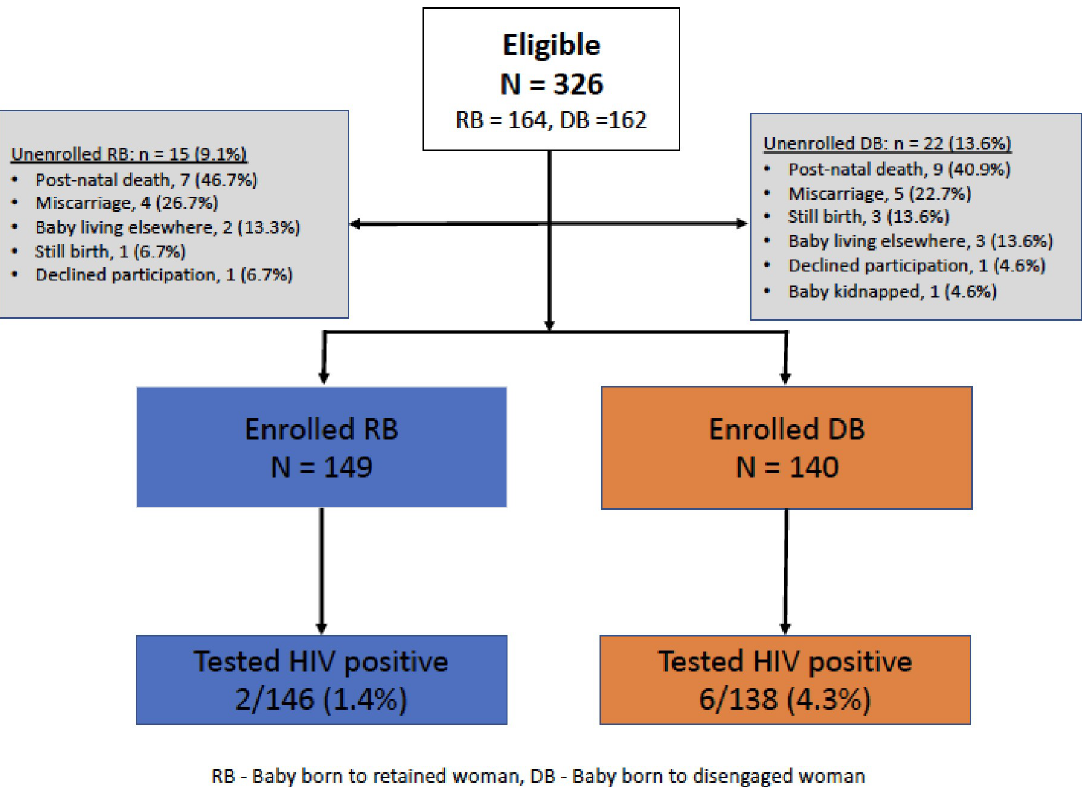
Fig 2. Study consort diagram showing infants born to HIV positive retained women (RB) and disengaged women (DB) enrolled in a community outreach study between July 2017 –July 2018 from six Kampala City Council public municipal clinics in Uganda. https://doi.org/10.1371/journal.pone.0251413.g002 Table 3. Demographic, clinical characteristics and outcomes of babies born to retained and disengaged women in a PMTCT program in Uganda. Characteristic Babies of Retained Women (N = 149) Babies of Disengaged Women (N = 140) P Value Age (months) at study enrollment, Median